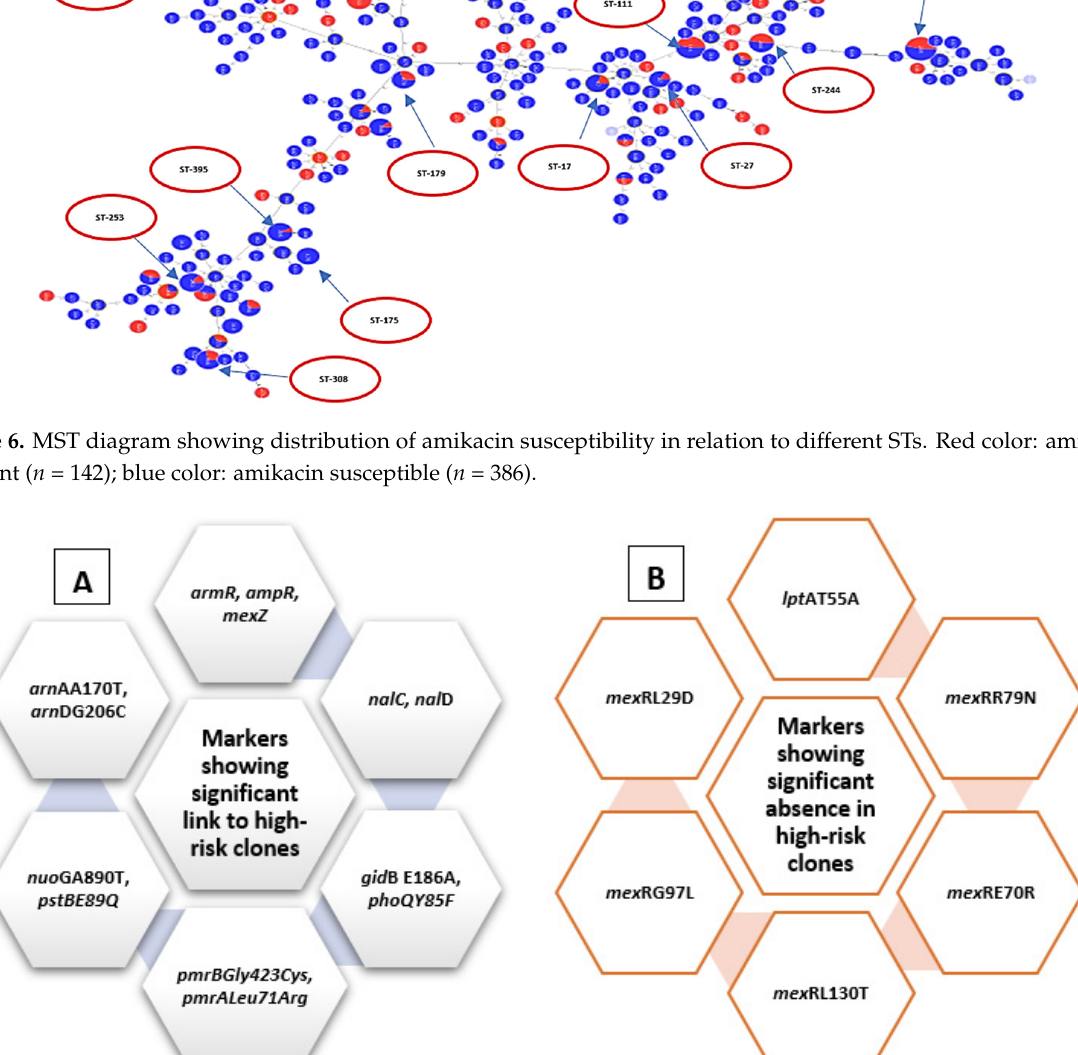
Table 3. Amikacin molecular markers showing significant associations with specific high-risk clones. Figure 7. Summary diagram showing amikacin-related molecular markers. The figure summarizes markers showing significant presence in high-risk clones ( A ) and those showing significant absence in relation to high-risk clones ( B ).